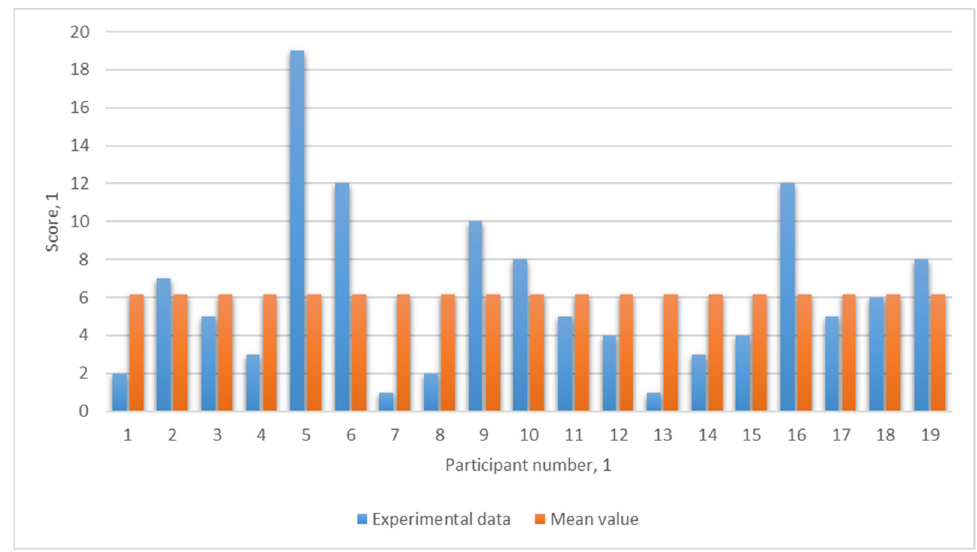
Figure A2. An example of the experimental data: differential gear-based design joint, velocity control mode, task 2. Experimental data showbn in blue, mean values shown in orange.